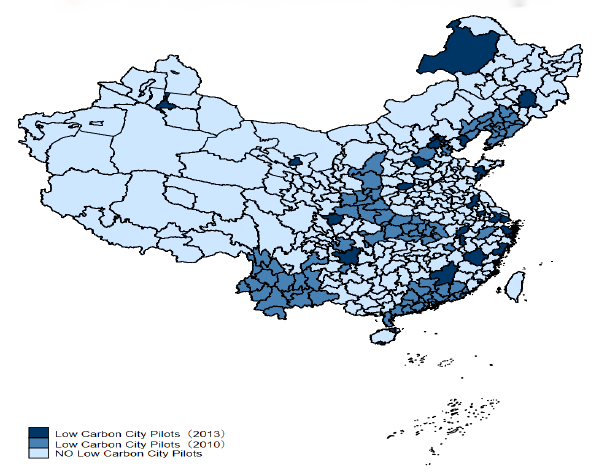
Figure 1. Location distribution of LCCP.